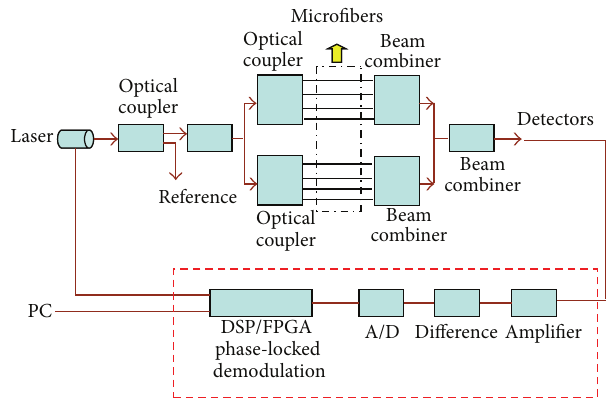
Figure 7: Experimental setup for molecular contaminants sensor based on an array of microfibers with nanoscale-structured film.